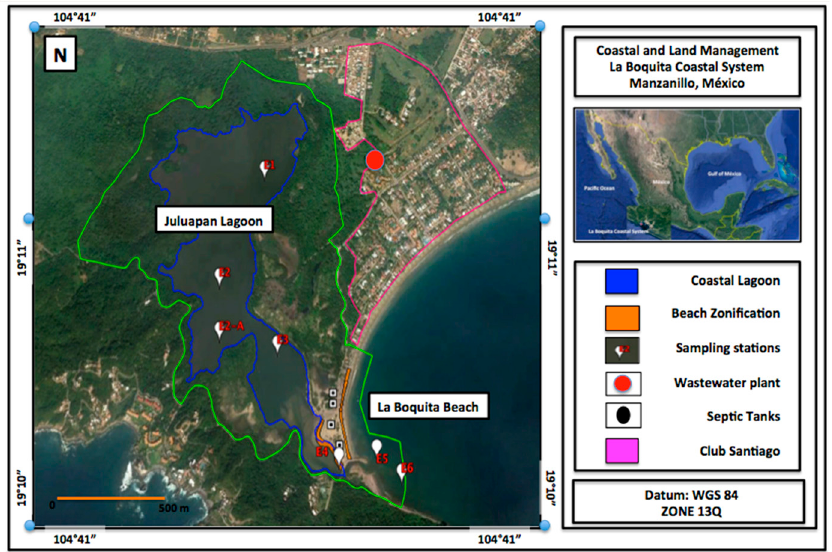
Figure 1. Study area showing the La Boquita coastal system (LBCS).